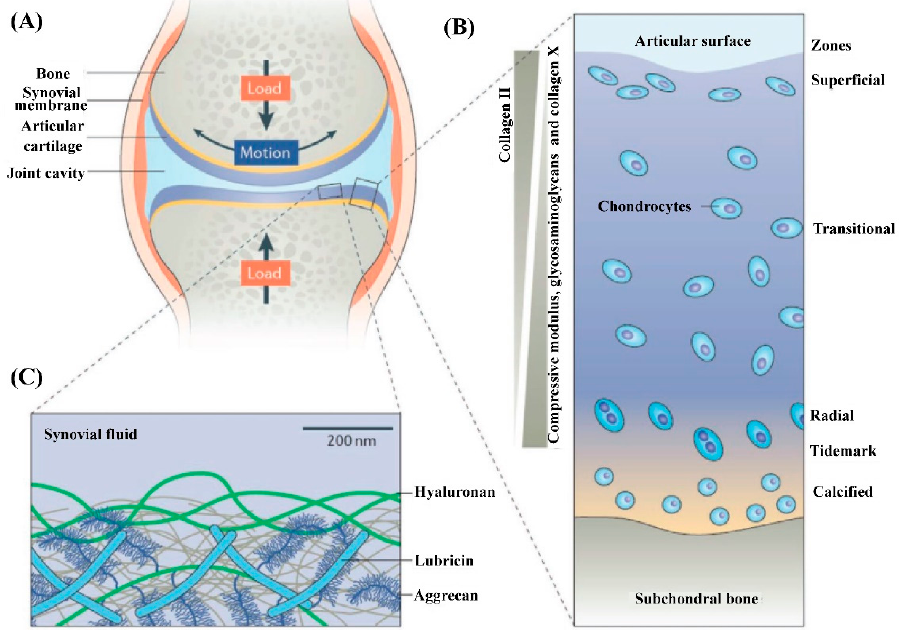
Figure 1. Illustration of the components and structure of AC. ( A ) The knee synovial joint is mainly composed of the synovial membrane, AC, and the synovial fluid within the synovial cavity. ( B ) AC is characterized by its layered structure. Chondrocytes make up less than 5% (volume fraction) of AC. The main composition of ECM, type II collagen, glycosaminoglycans, collagen X, and the depth- dependent modulus, are indicated. ( C ) Illustration of the outer surface of AC that determines the lubrication performance of AC. Glycosaminoglycans, including hyaluronic acid (HA) and aggrecan, as well as lubricin and phospholipids (are not shown here) synergically assemble to form a lubrication layer outer of the AC surface to determine its remarkable lubrication at high pressure. Reprinted with permission from Ref [4]. Copyright 2021,